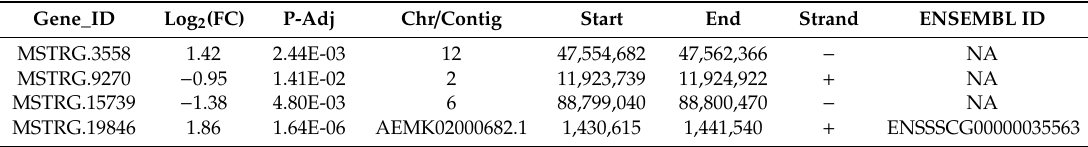
Table 2. Differentially expressed lncRNAs identified in the porcine endometrium after 7 days of fold change.